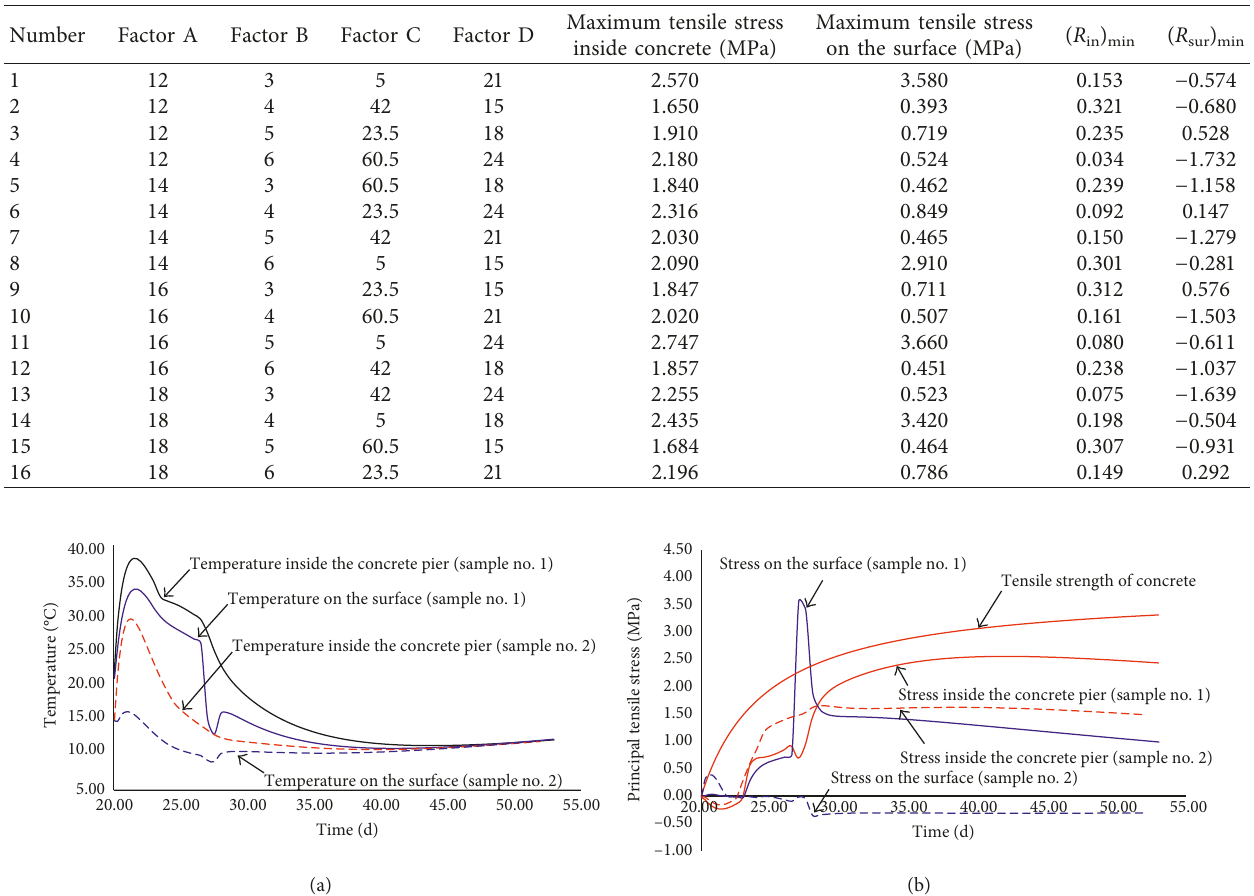
Figure 4: Maximum temperature and maximum tensile stress curves of pier concrete for sample no. 1 and no. 2: (a) temperature curve; (b) tensile stress